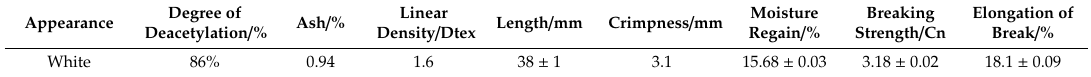
Table 1. Basic performances of chitosan fiber.